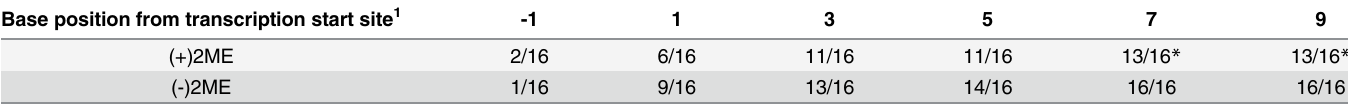
Table 2. G (cid:1) C to C (cid:1) G transversions at exon 1 of the Tbx5 gene in R1 mouse ESCs subjected to oxidative stress. Base position from transcription start site 1